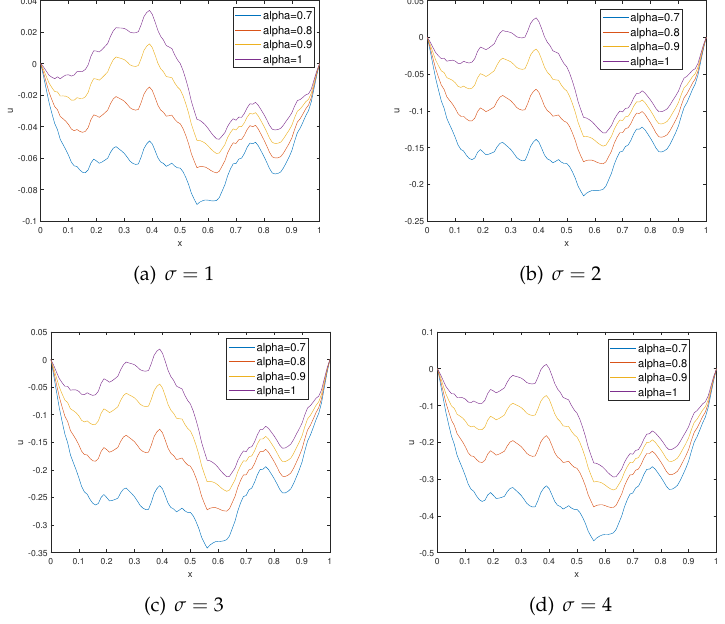
Figure 11. The approximation solutions of Example 2 (case (2)) with t =